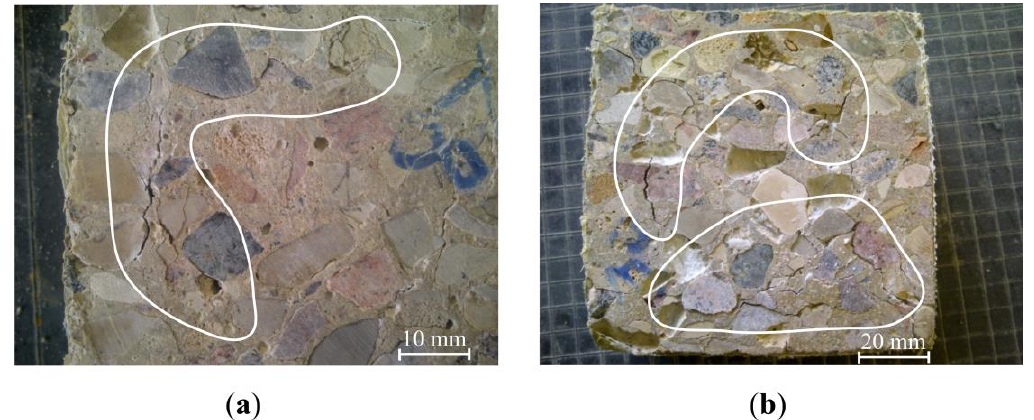
Figure 14. View of the samples after 56 frost resistance testing cycles, ( a ) CW1 sample; ( b ) CW2 sample.